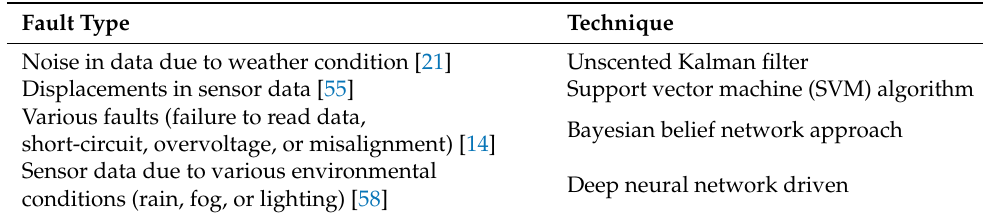
Table 5. Demonstration of fault types and prognostic health management (PHM) analysis for the light detection and ranging